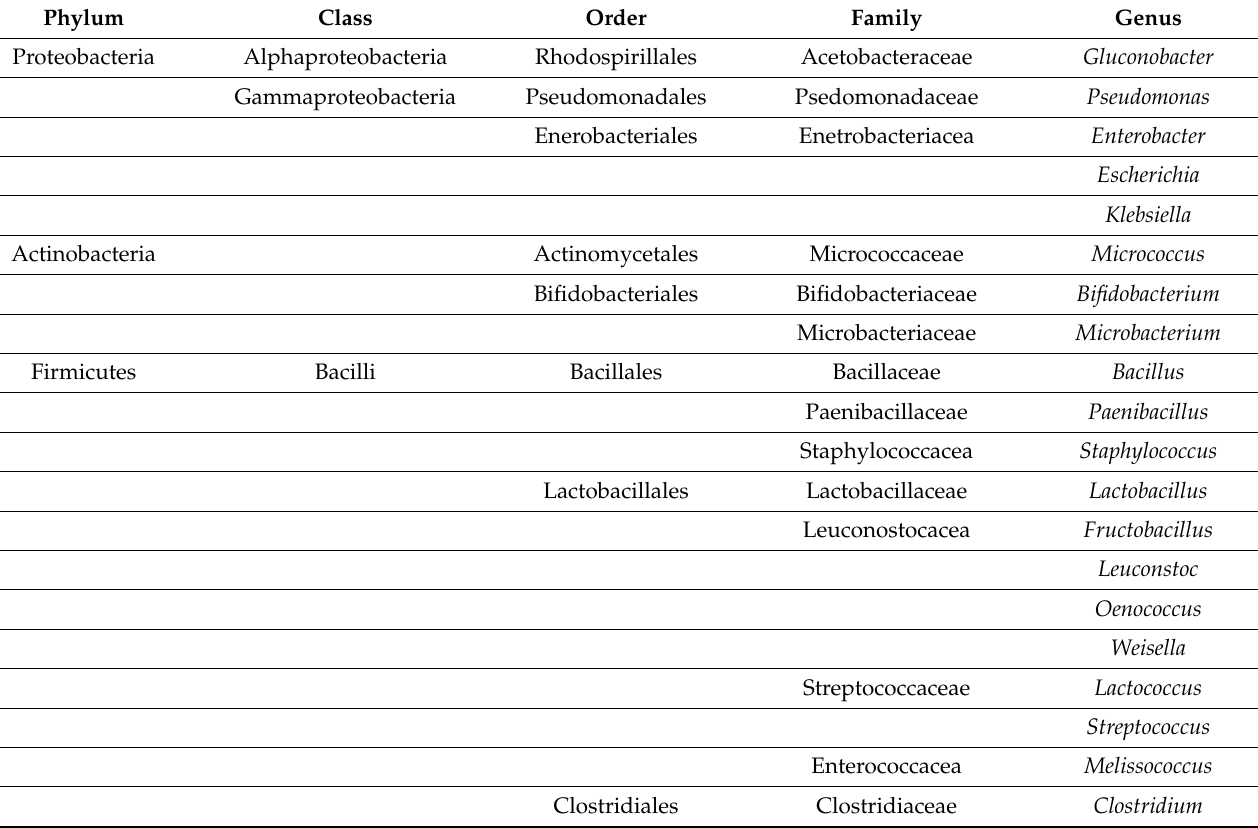
Table 1 is based on data from studies of Anderson et al., 2013 [42], Corby-Harris et al., 2014 [43], Bovo et al., 2018 [44] and Manirajan et al., 2016